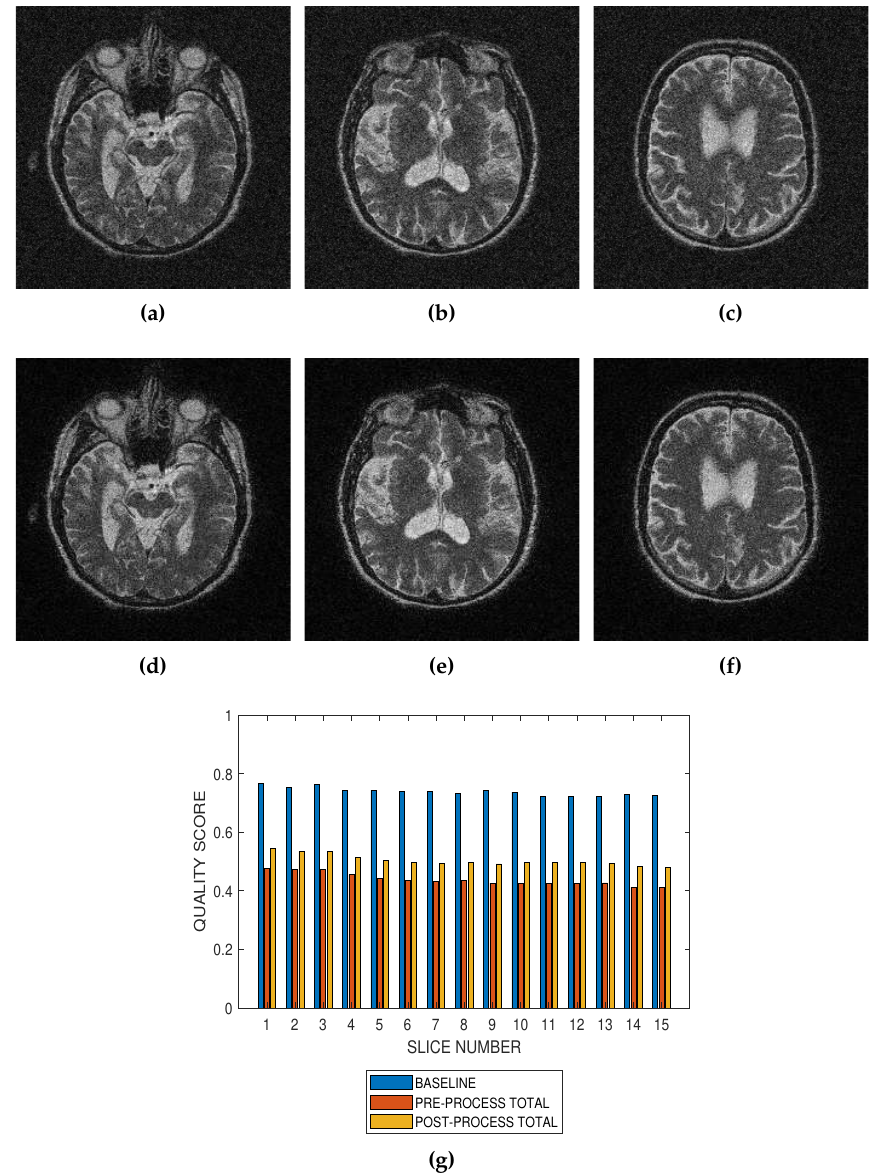
Figure 8. Application of the proposed method to the assessment of an image enhancement algorithm. ( a – c ) are slices numbers 20, 27 and 34, respectively in a T2 MRI volume degraded with 8 percent Rician noise. ( d – f ) are the slices displayed in ( a – c ) but their quality have been enhanced using a bilateral filter. ( g ) The baseline quality score of the original image, the predicted total quality indices of 12 successive T2 MRI slices in a volume data before and after enhancement with a bilateral